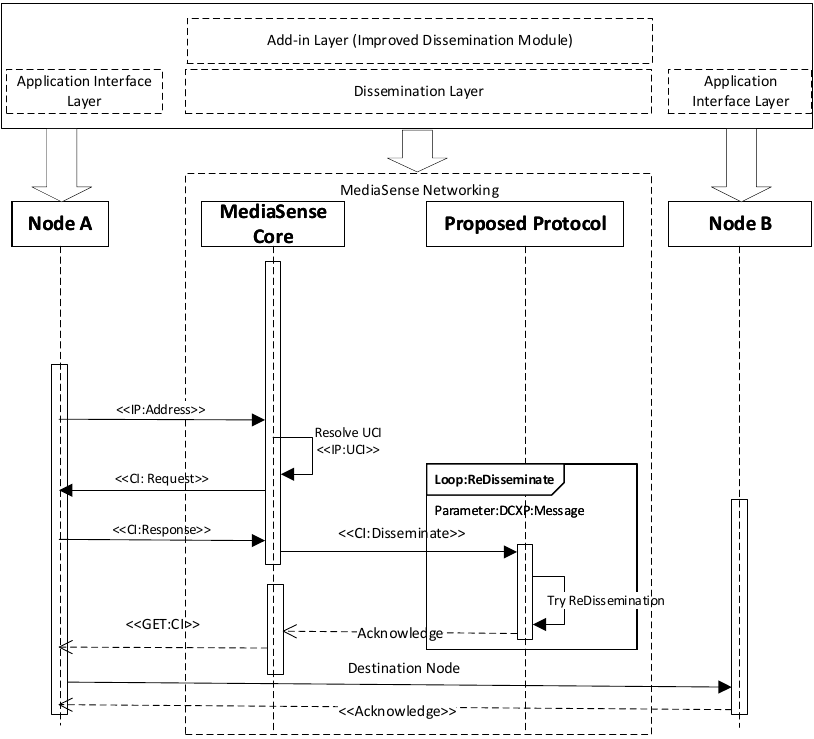
Figure 5. Interaction Model of Peer Nodes within